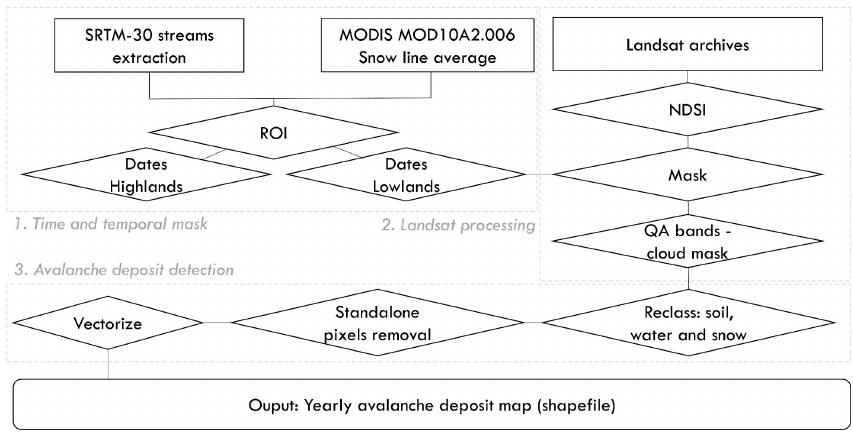
Figure 3. Flow chart for Snow Avalanche Frequency Estimation (SAFE) using Landsat archives in Google